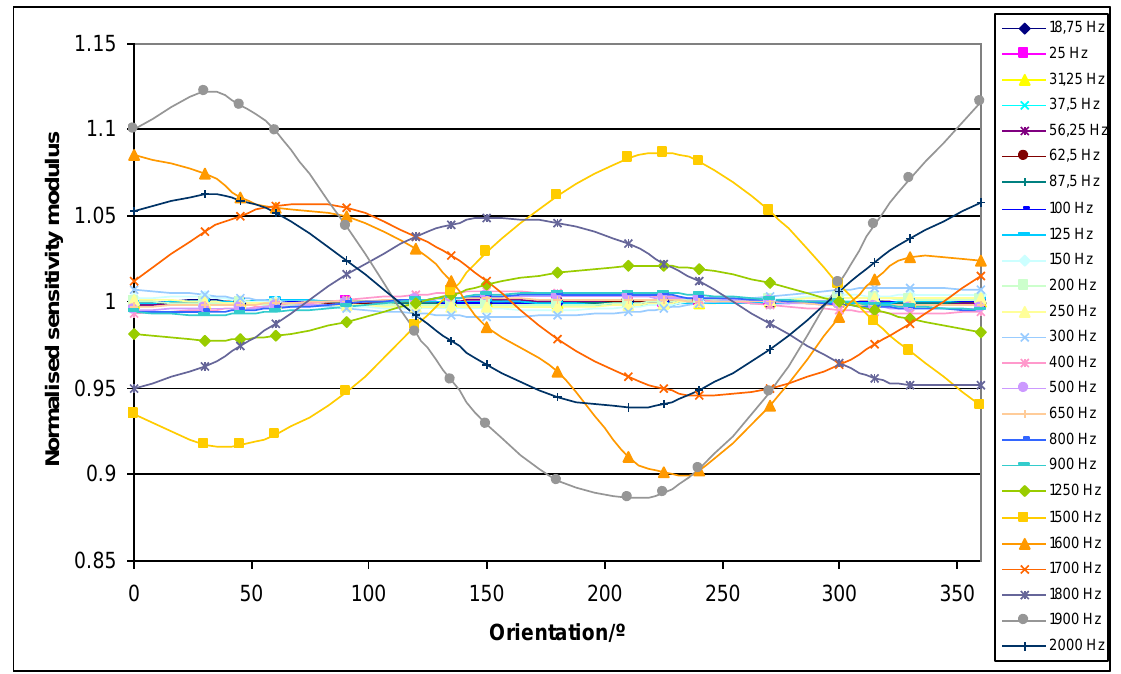
Figure 4. Each curve represents the sensitivity modulus divided by the mean sensitivity modulus for a different excitation frequency versus the different orientations of the laser vibrometer beam location around a circumference of radius 1 cm for the Kistler 9175B sensor (2 kg loading